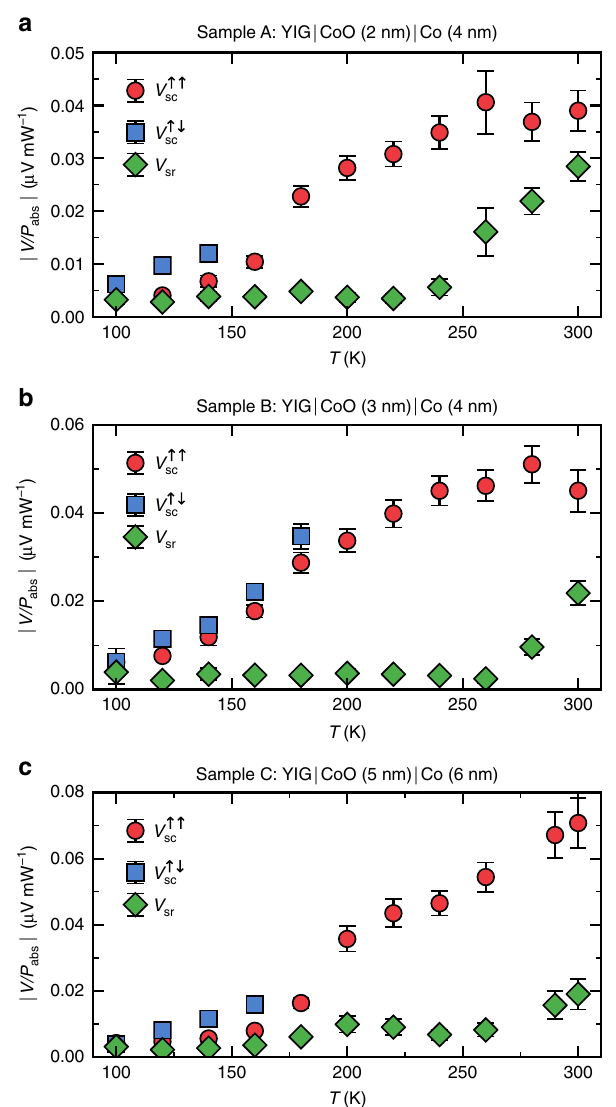
Fig. 2 Temperature dependence of voltage signal amplitudes. a – c Amplitudes of V sc for parallel and antiparallel alignment and V sr normalized by the absorbed microwave power as a function of temperature for a sample A, b sample B, and c sample C. Antiparallel alignment of Y 3 Fe 5 O 12 (YIG) and Co is observed until a critical, sample-dependent temperature. The temperature range from 100 to 300 K was chosen as below 100 K a decreased signal-to-noise ratio impedes straightforward data analysis, whereas higher temperatures were avoided to prevent possible undesirable degradation of the multilayer stack. The error bars are calculated by error propagation including errors of the spin signal amplitude and absorbed power amplitude, as well as a systematic error estimated by the measurement device